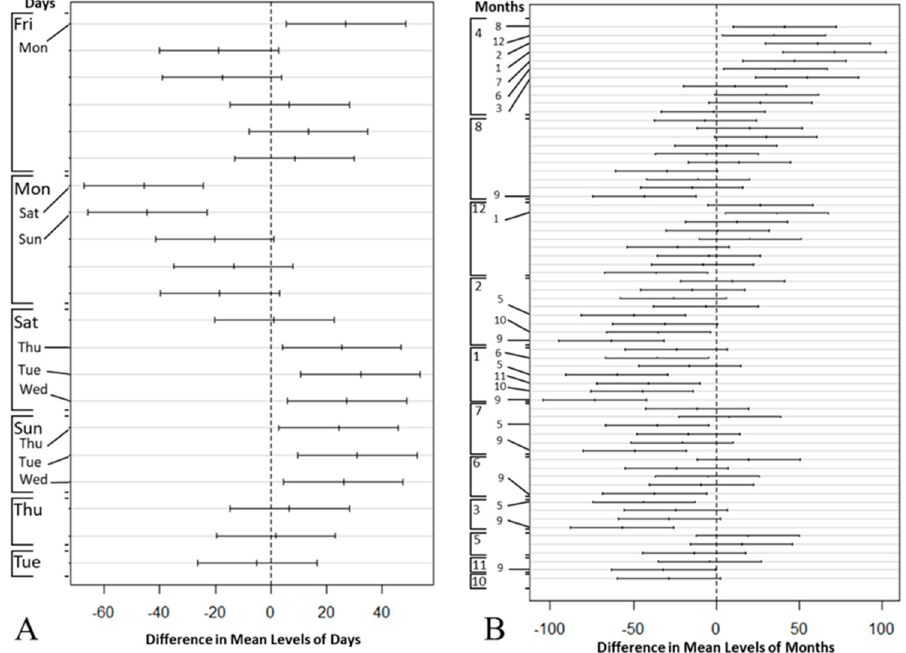
Figure 6. Tukey’s test: compare the mean difference of ED patient arrivals by ( A ) week day and ( B ) month.